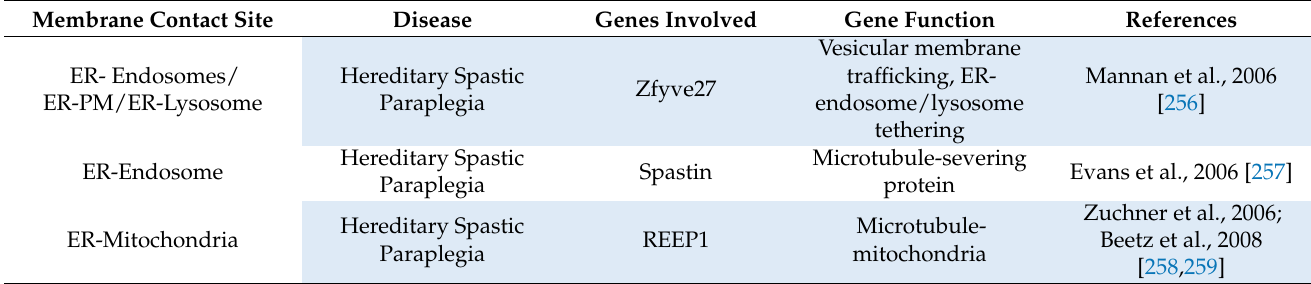
Table 2. Table summarizing human conditions caused by genetic deficits in genes important for MCSs between organelles. Membrane Contact Site Disease Genes Involved Gene